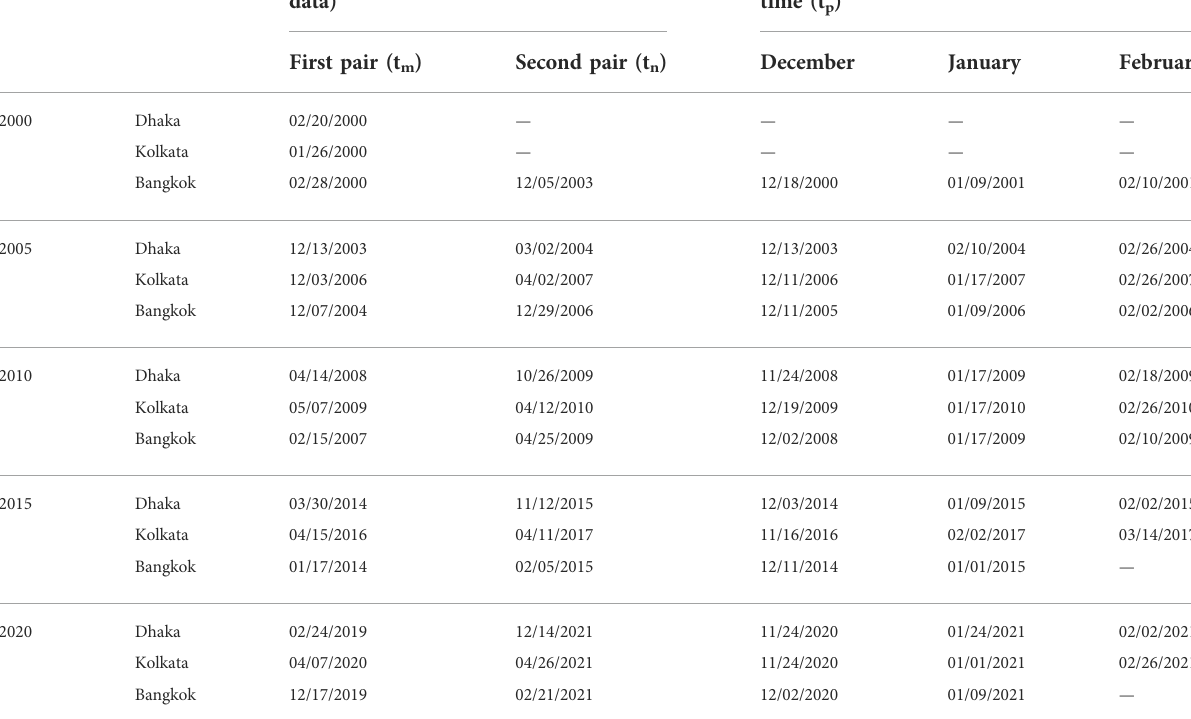
TABLE 2 MODIS and Landsat data used for the ESTARFM data